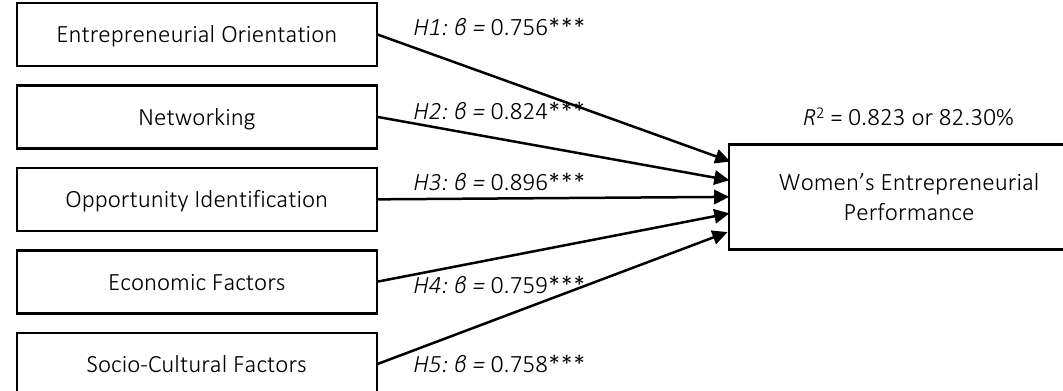
Figure 2. Regression results